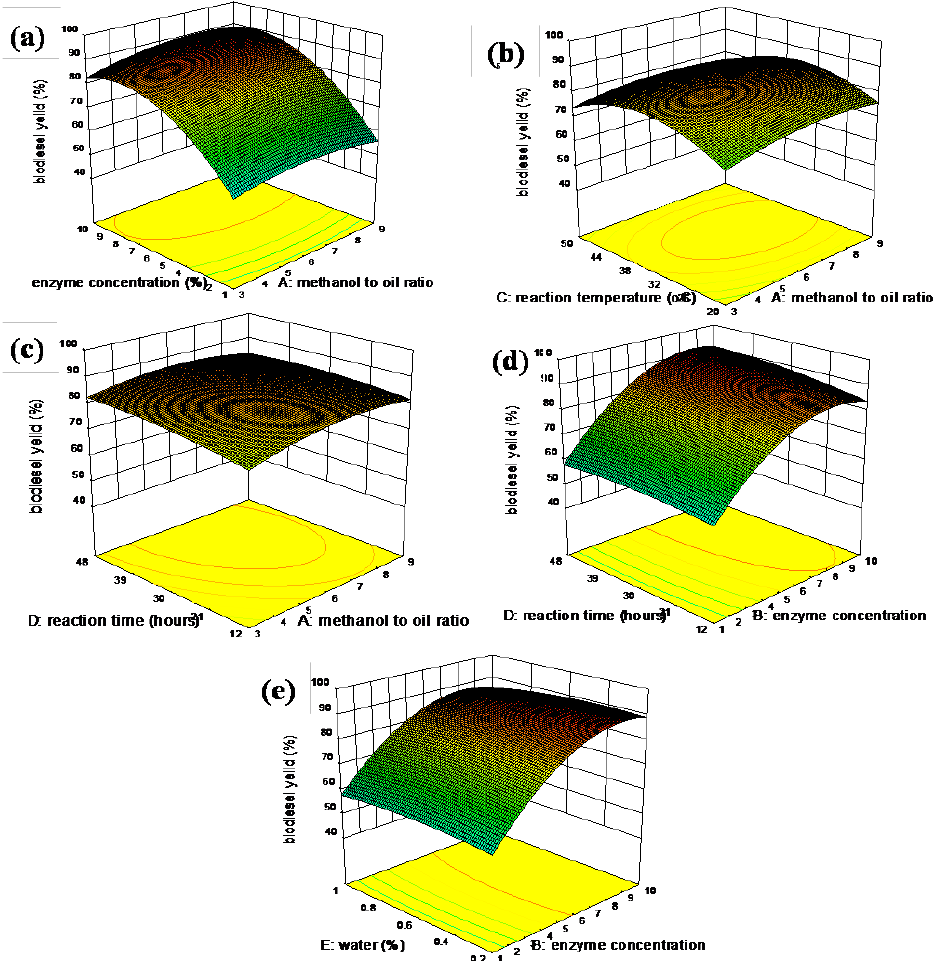
Figure 9. Response surface graphs of significant first order interaction terms ( a ) A × B, ( b ) A × C, ( c ) A × D, ( d ) B × D and ( e ) B × E.